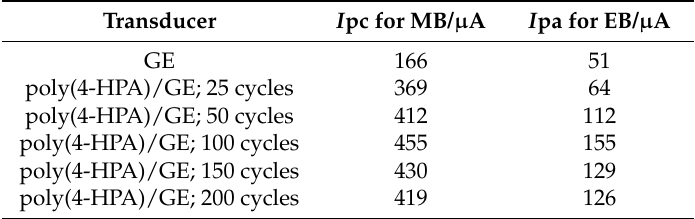
Current peak values obtained from MB reduction and EB oxidation for GE and poly(4-HPA)/GE polymerized at different potential cycles containing the immobilized oligonucleotide (mean, n = 3). Transducer I pc for MB/ µ A